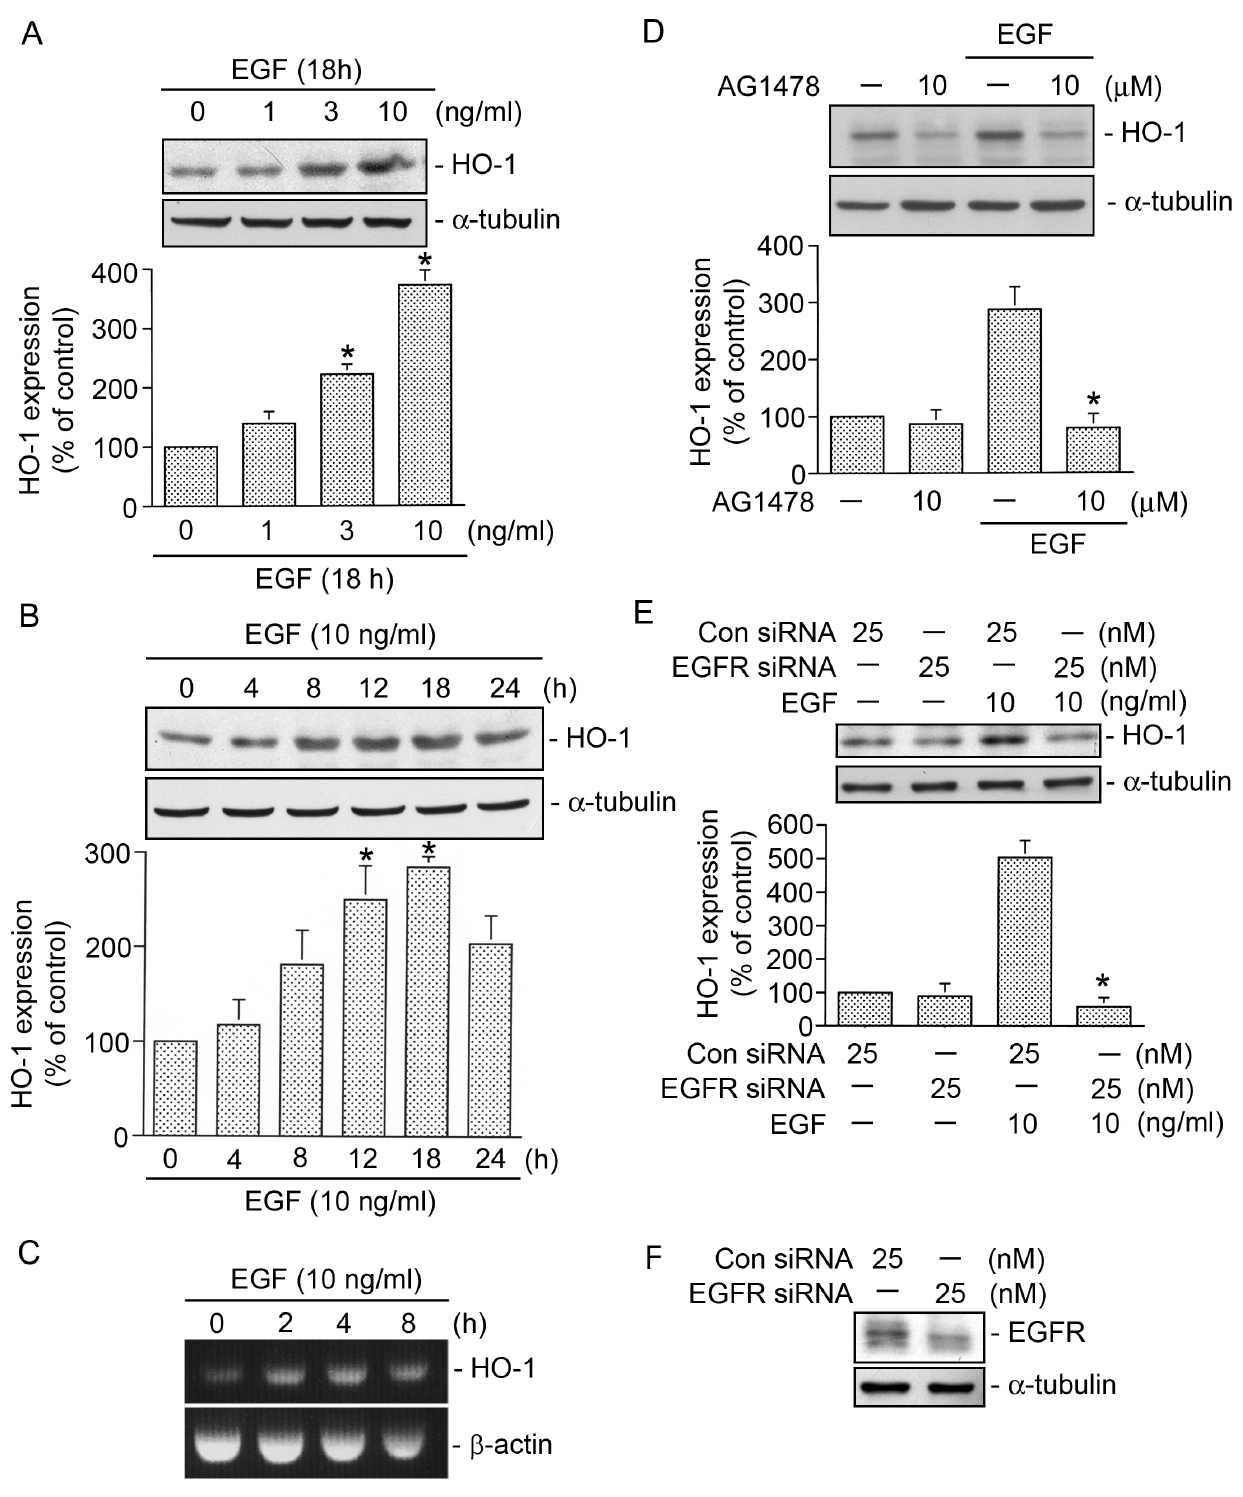
Figure 1. Epidermal growth factor (EGF) induces heme oxygenase (HO)-1 expression. A, HT-29 cells were incubated with various concentrations of EGF for 18 h, and then HO-1 and a -tubulin protein levels were determined. Immunoblots are representative of three experiments, which are presented as the mean 6 SEM. * p , 0.05, compared to the control group. B, Cells were incubated for various time intervals with EGF (10 ng/ ml), and then HO-1 and a -tubulin protein levels were determined. Immunoblots are representative of three experiments, which are presented as the mean 6 SEM. * p , 0.05, compared to the control group. C, Cells were treated for various time intervals with EGF (10 ng/ml). Total RNA was prepared, and a RT-PCR was carried out as described in ‘‘Materials and Methods’’. Taces represent results from three independent experiments. D, Cells were pretreated for 30 min with 10 m M AG1478 and then stimulated with 10 ng/ml EGF for another 18 h. After incubation, HO-1 and a -tubulin protein levels were determined. Immunoblots are representative of three experiments, which are presented as the mean 6 SEM. *p , 0.05, compared to EGF